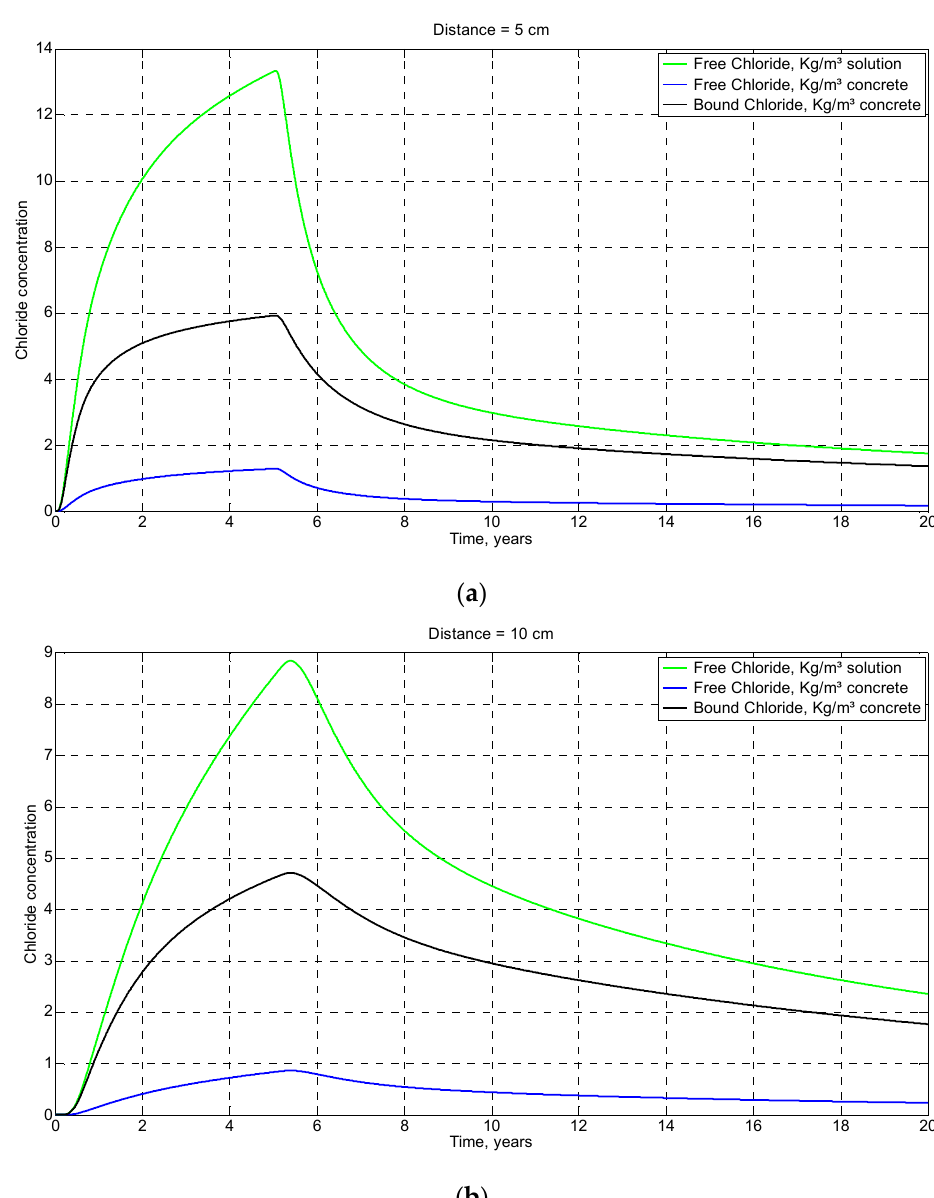
Figure 18. Time dependent concentration of C f,s (free chloride in kg/m 3 solution), C f,c (free chloride in kg/m 3 concrete) and C b (bound chloride in kg/m 3 solution) at ( a ) x = 5 and ( b ) 10 cm.